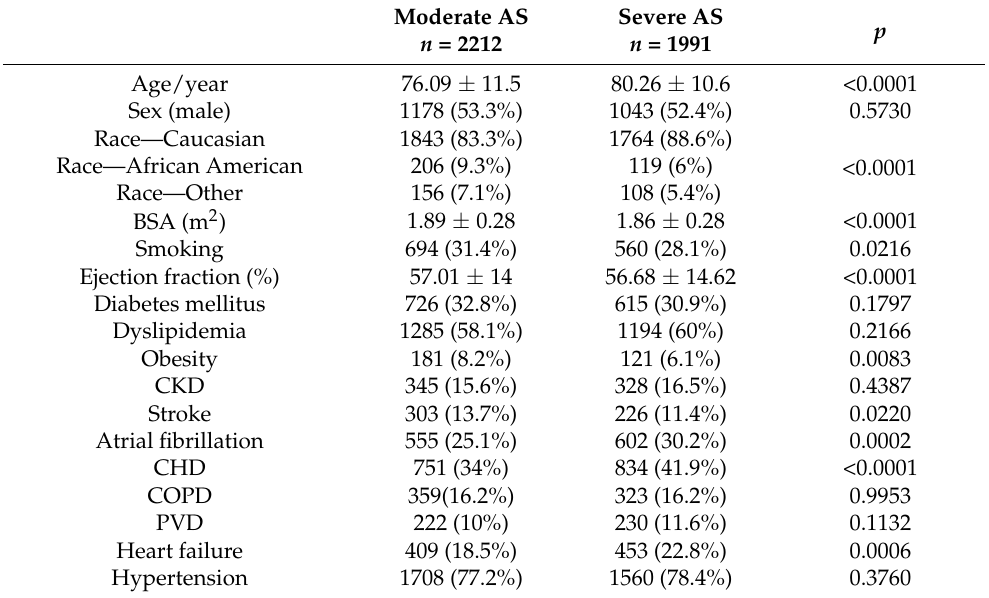
Table 1. Characteristics of patients with AS on their first echocardiography during the study period